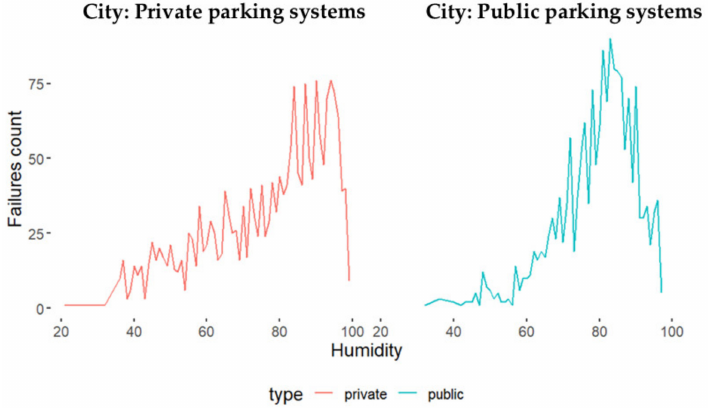
Figure 21. Humidity values for failure events for city for private parking systems ( left ) and city for public parking systems ( right